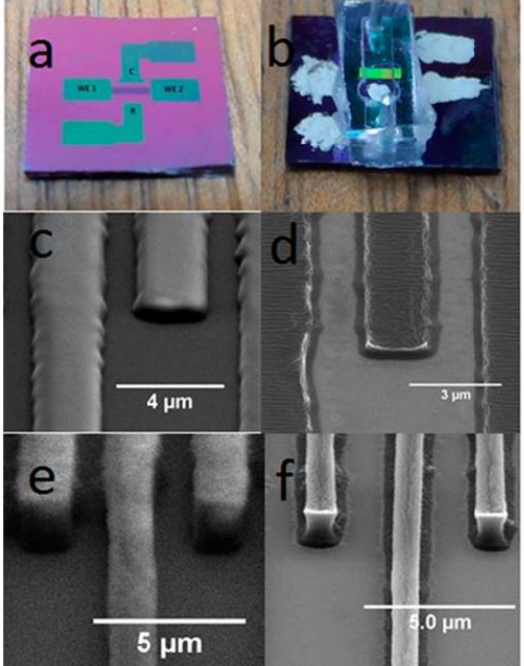
Figure 4. ( a ) 3D carbon IDEA sensor on a Si wafer. WE1 and WE2 are contact pads for the generator and the collector, respectively. C and R are counter and reference electrodes, respectively. ( b ) 3D carbon IDEA integrated with PDMS channels. The reference electrode is coated with Ag/AgCl ink, and contact pads are coated with silver paste for better electrical connection. ( c , e ) Scanning electron microscopy (SEM) images (tilted view 60°) under 10,000 × magnification of SU-8 IDEA patterning before pyrolysis; height = 0.6 and 2.1 μm, respectively. ( d , f ) Carbon IDEA after pyrolysis; height = 0.22 and 0.59 μm, respectively. Reprinted with permission from [54]. Copyright © 2022 , American Chemical Society.